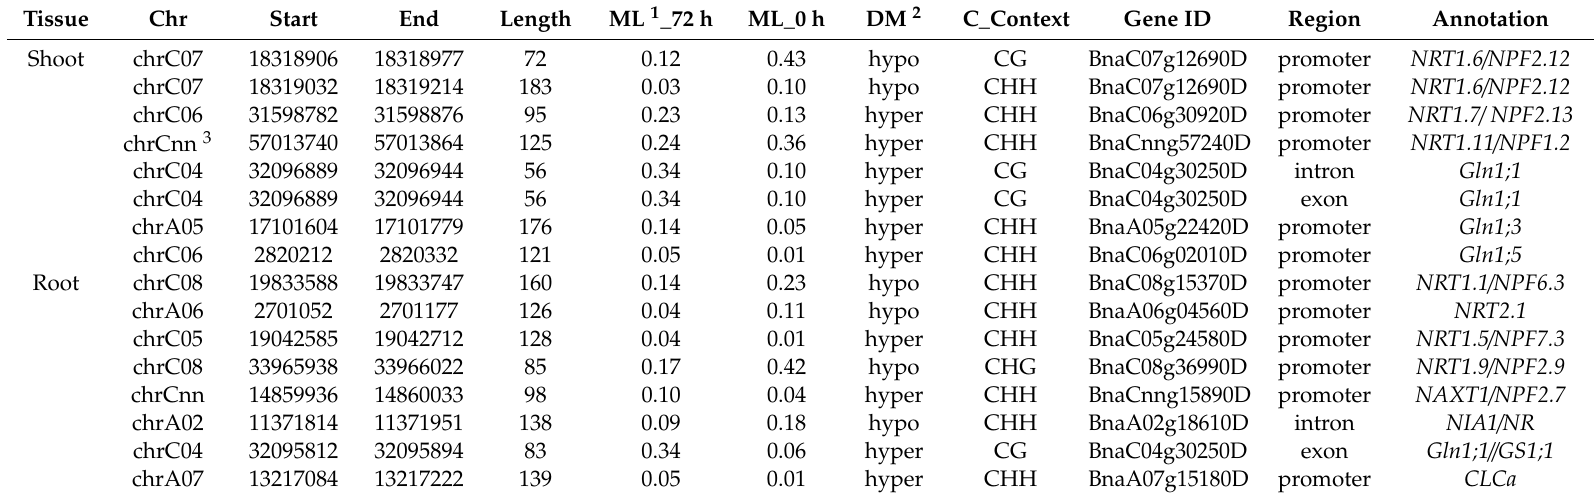
Table 1. Di ff erential DNA methylation of some key N-metabolism-associated genes in the shoots and roots under N